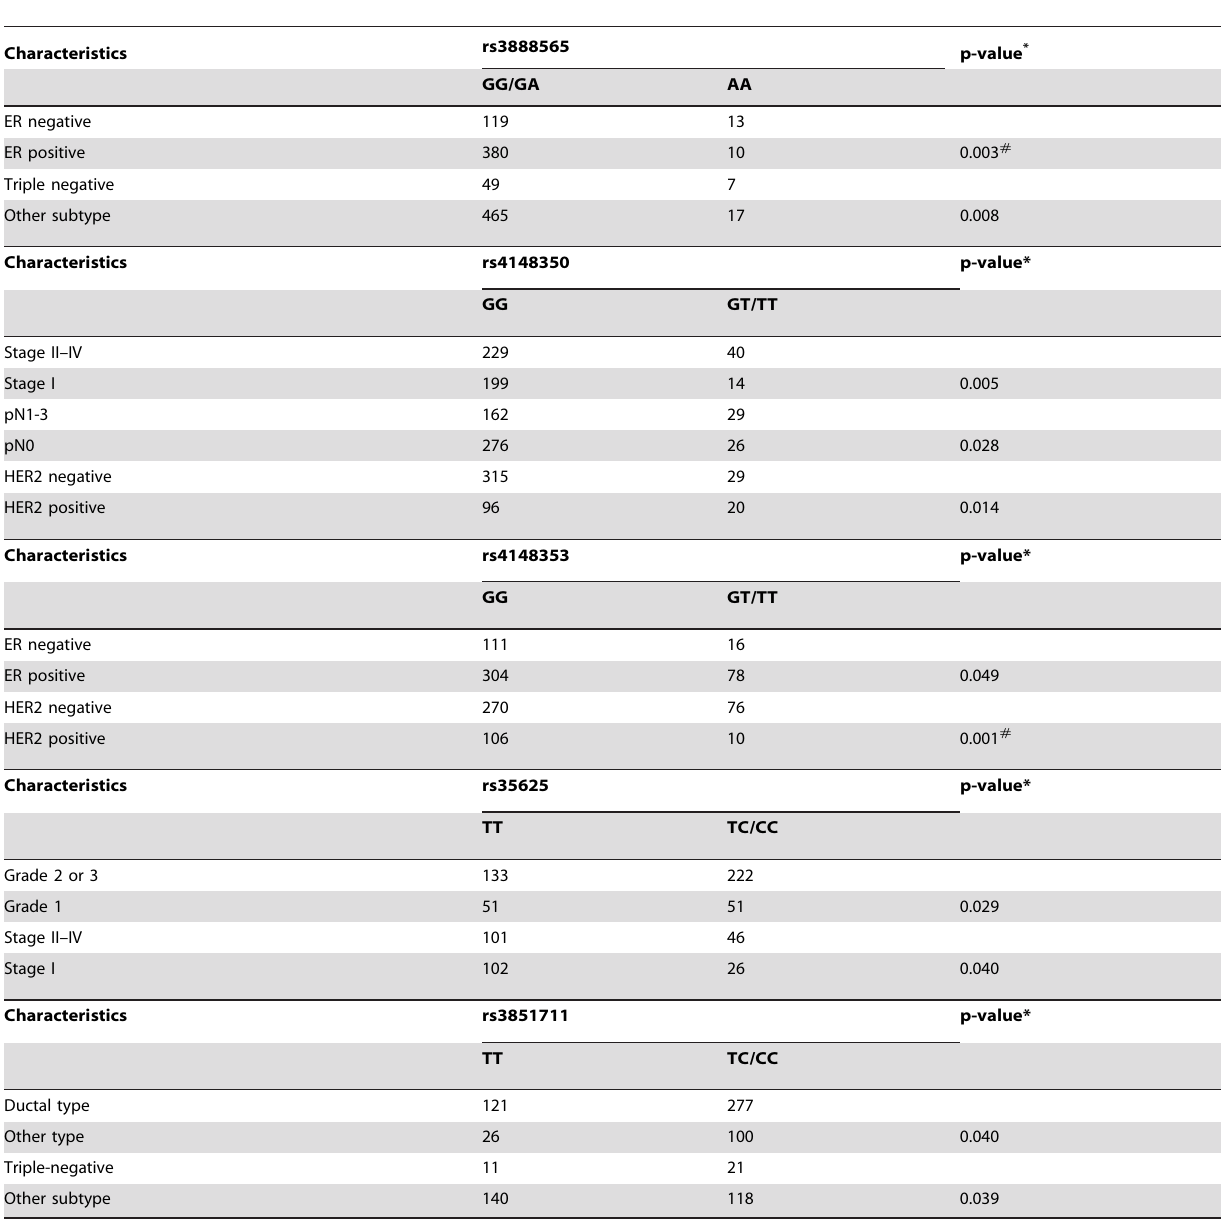
Table 5. Significant associations of ABCC1 polymorphisms with clinical